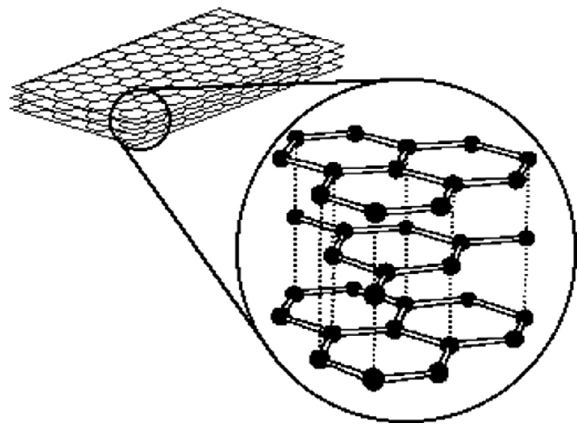
Figure 7. Crystalline graphite structure illustrating lubricious cleavage planes (McIntosh).